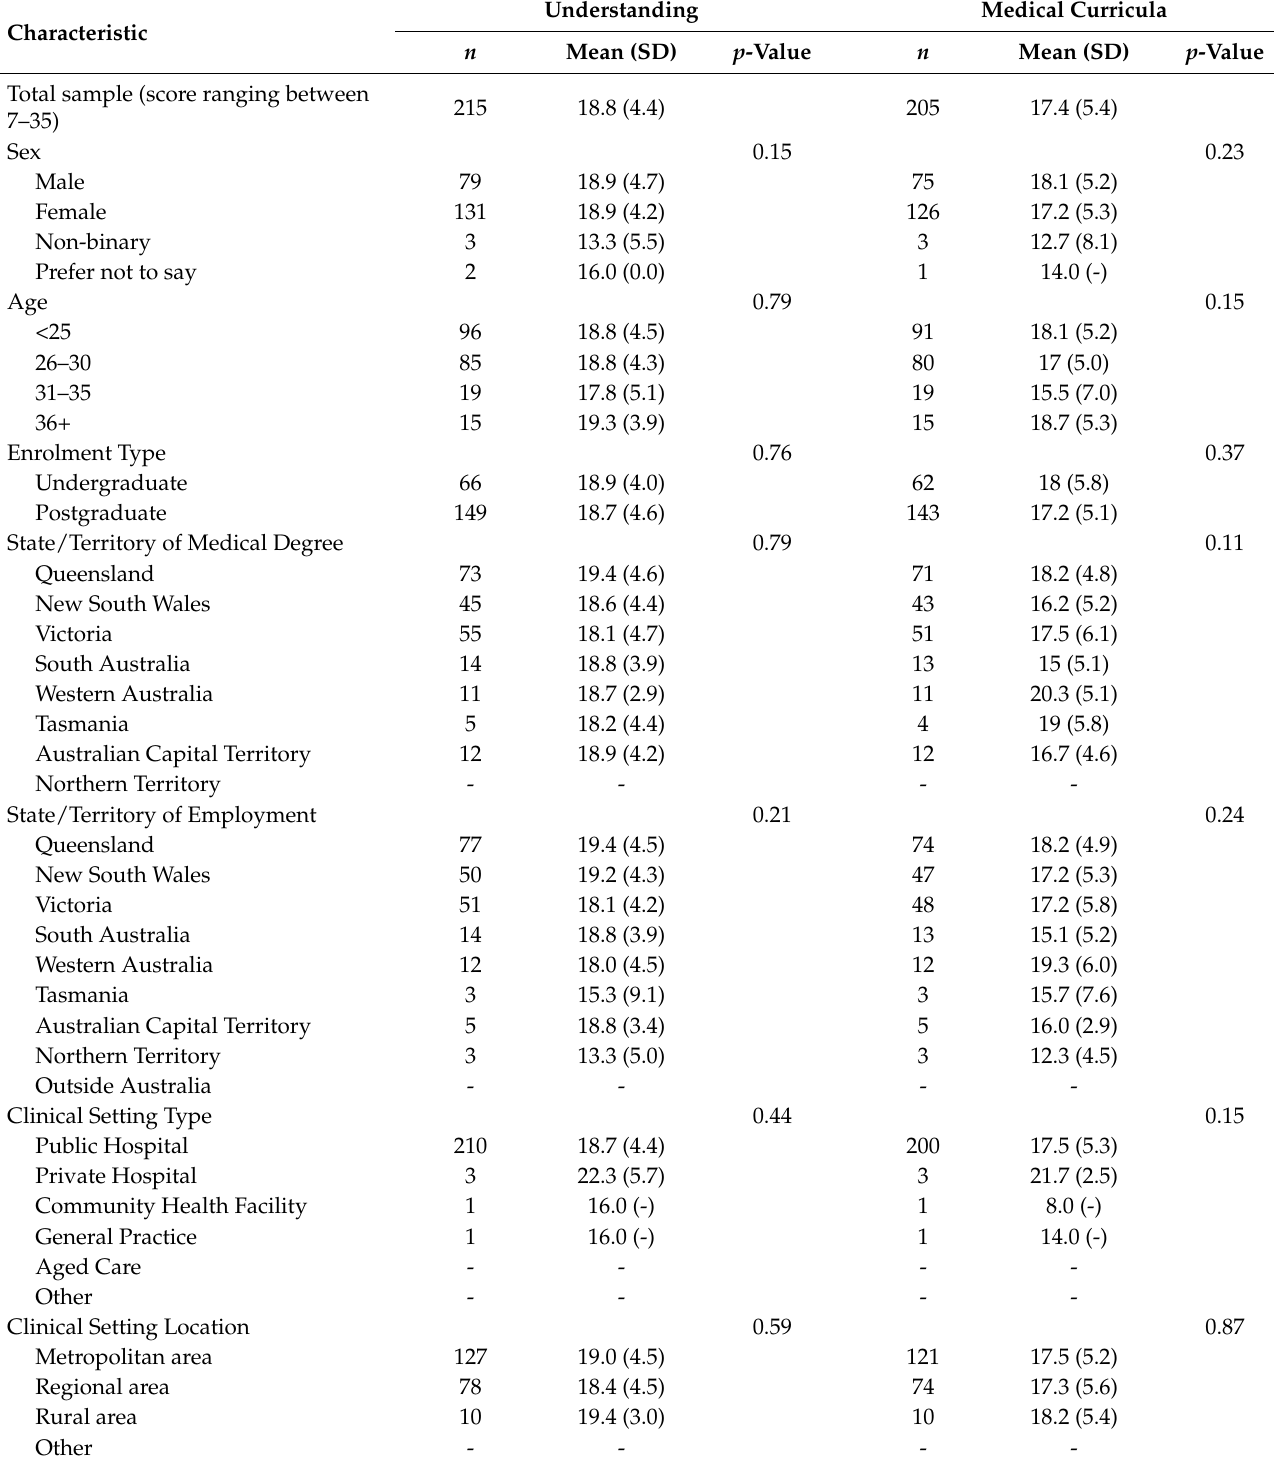
Table 2. Subscale scores (minimum: 7; maximum: 35) for perceptions related to (i) understanding of the lymphatic system and lymphoedema, and (ii) the extent to which the lymphatic system and lym- phoedema were covered in medical curricula, for the total sample and by participant